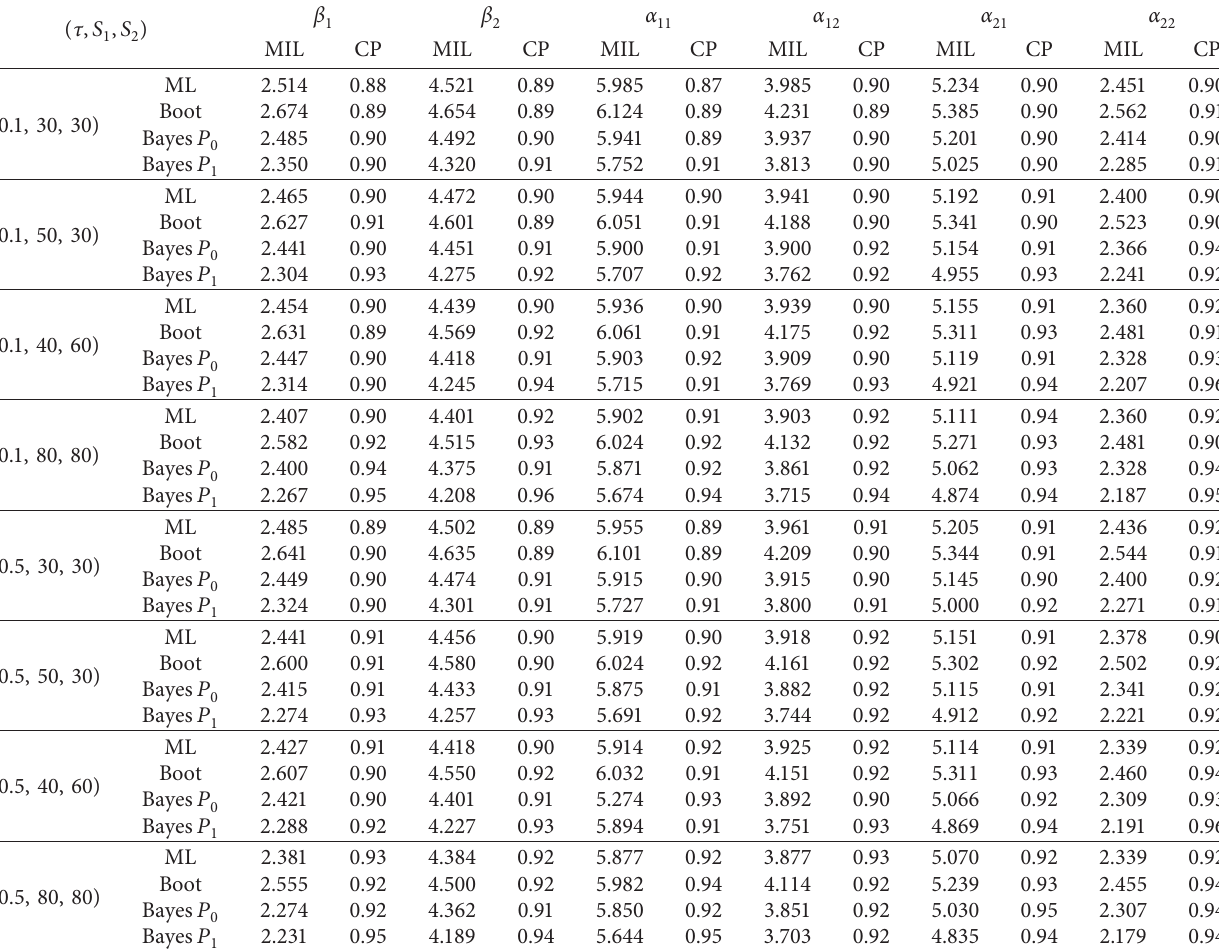
Table 8: The MILs and CPs of ML, boot, and Bayes methods under ω � 1 . 0 , 2 . 0 , 3 . 0 , 2 . 0 , 2 . 5 , 1 . 0 { }